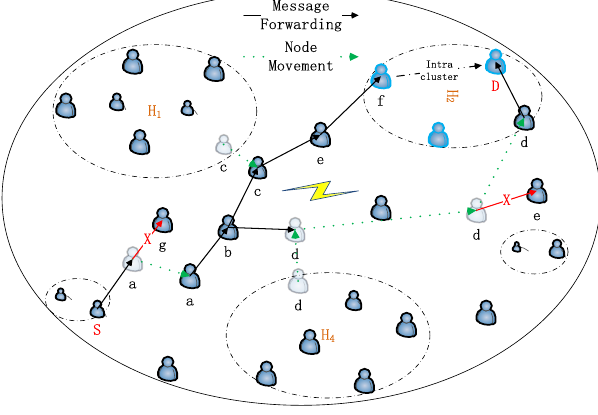
Figure 4. The process of inter-cluster